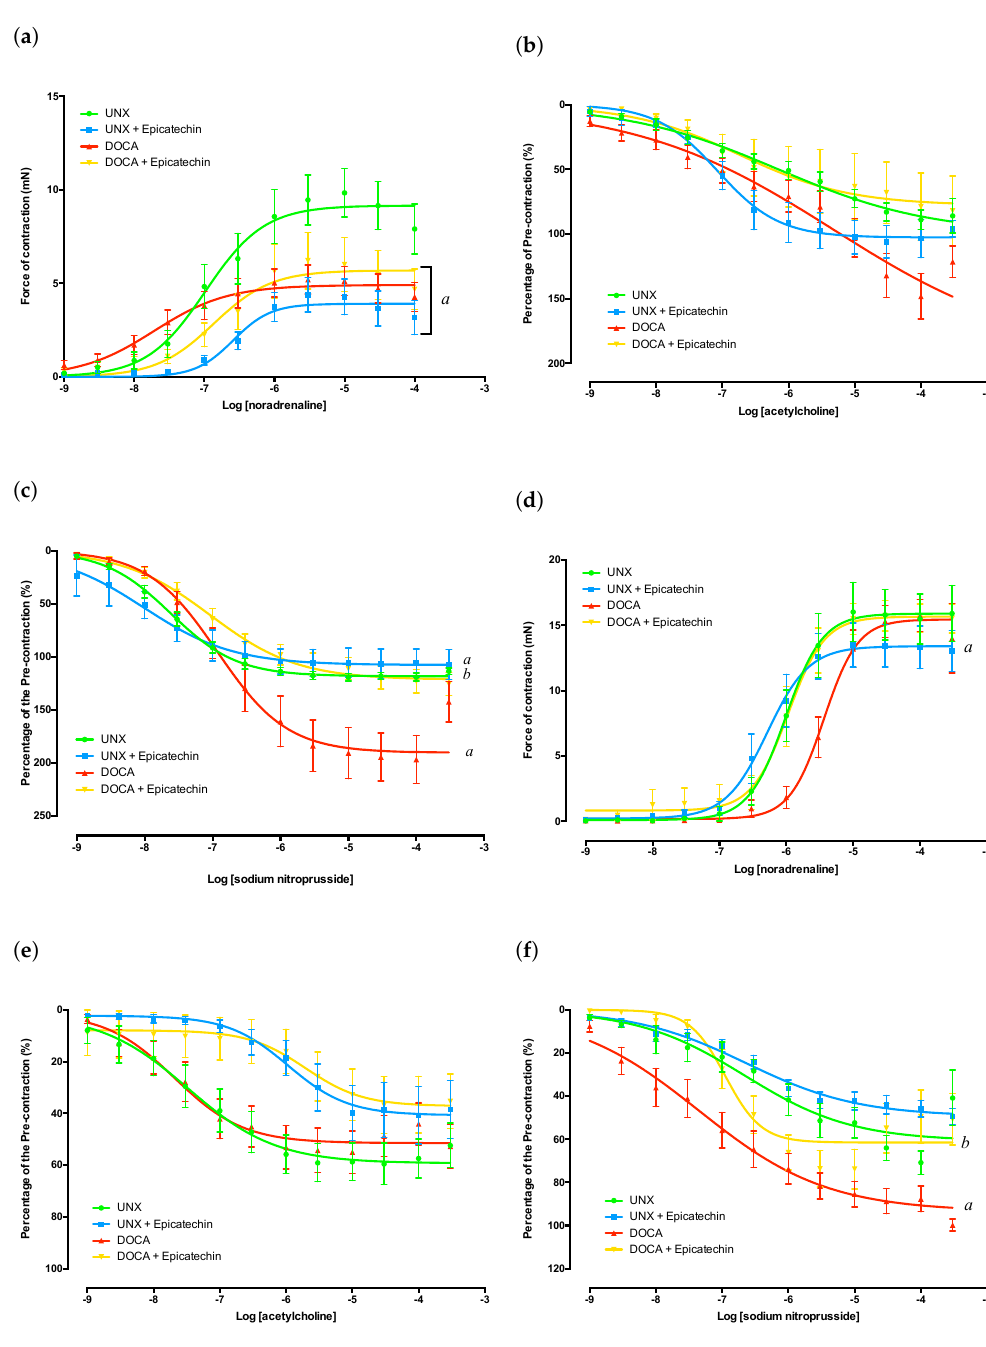
Figure 1. Vascular isolated organ bath experiments. ( a ) Aorta concentration response curve to NA; ( b ) Aorta concentration response curve to ACh following sub-maximal pre-contraction with NA; responses are presented as percentage of pre-contractile force; ( c ) Aorta concentration response curve to NaNO following sub-maximal pre-contraction with NA; responses are presented as the percentage of pre-contractile force; ( d ) Mesenteric concentration response curve to NA; ( e ) Mesenteric concentration response curve to ACh following submaximal precontraction with NA; responses are presented as the percentage of pre-contractile force; ( f ) Mesenteric concentration response curve to NaNO following submaximal precontraction with NA; responses are presented as the percentage of pre-contractile force. a p < 0.05 compared to UNX; b p < 0.05 compared to